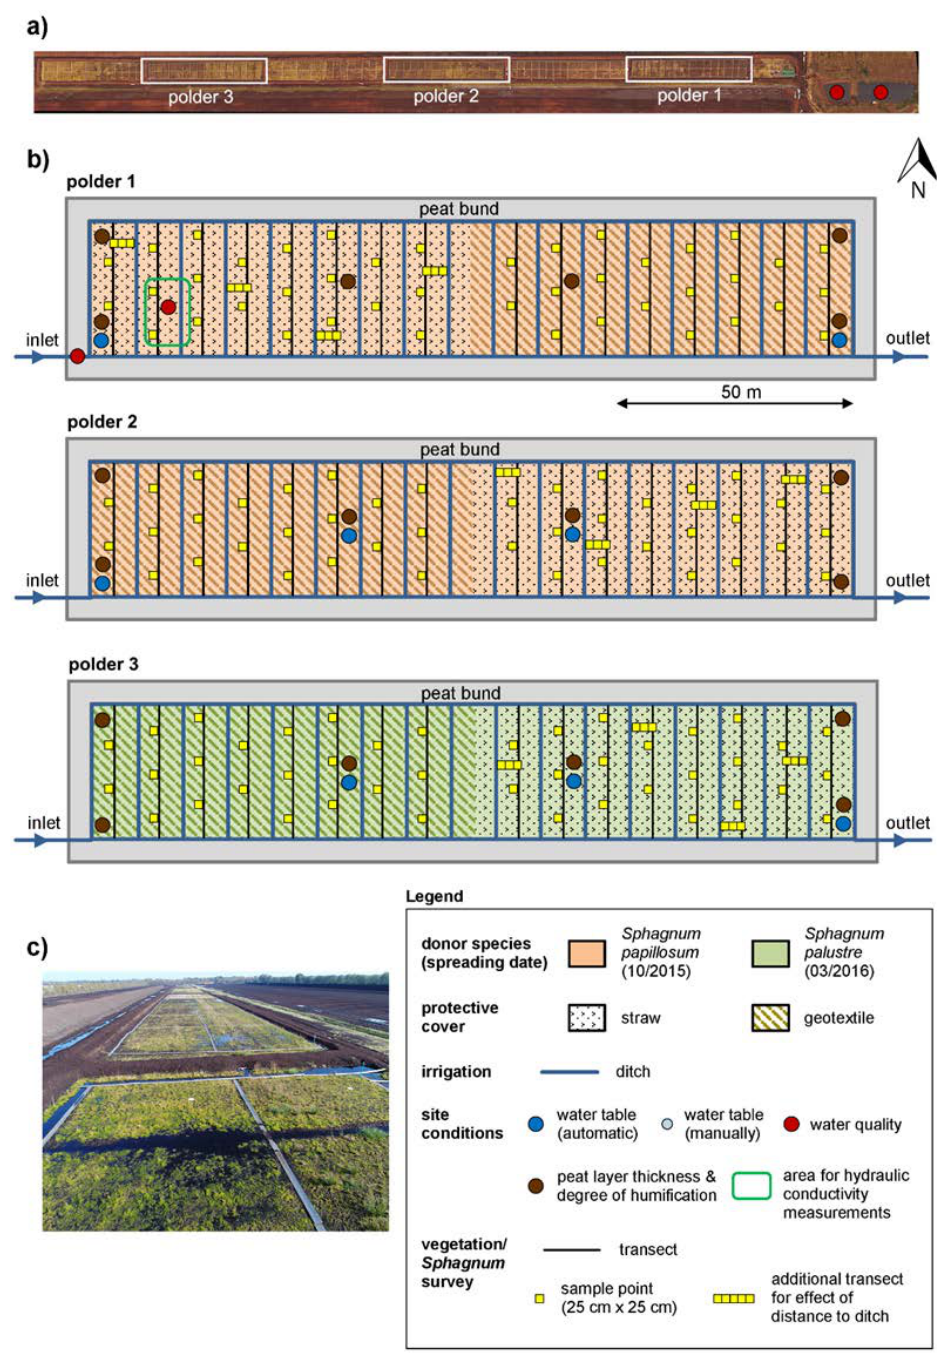
Figure 1. Sphagnum cultivation site “Drenth”. a) aerial view of the study site (March 2017); b) study site with sampling locations (vegetation, water, soil); c) cultivation site Drenth with surrounding peat extraction area (October 2017). Photos: Klasmann-Deilmann